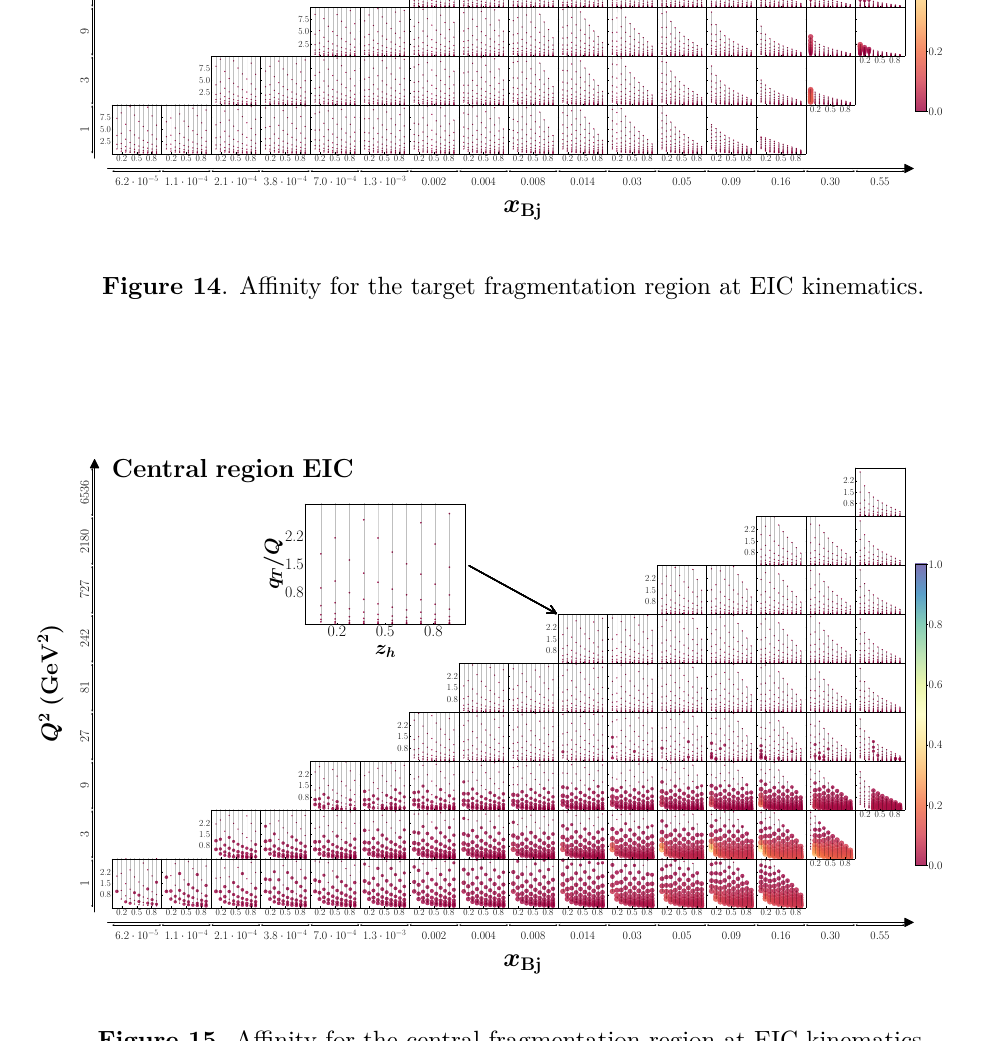
Figure 15 . Affinity for the central fragmentation region at EIC